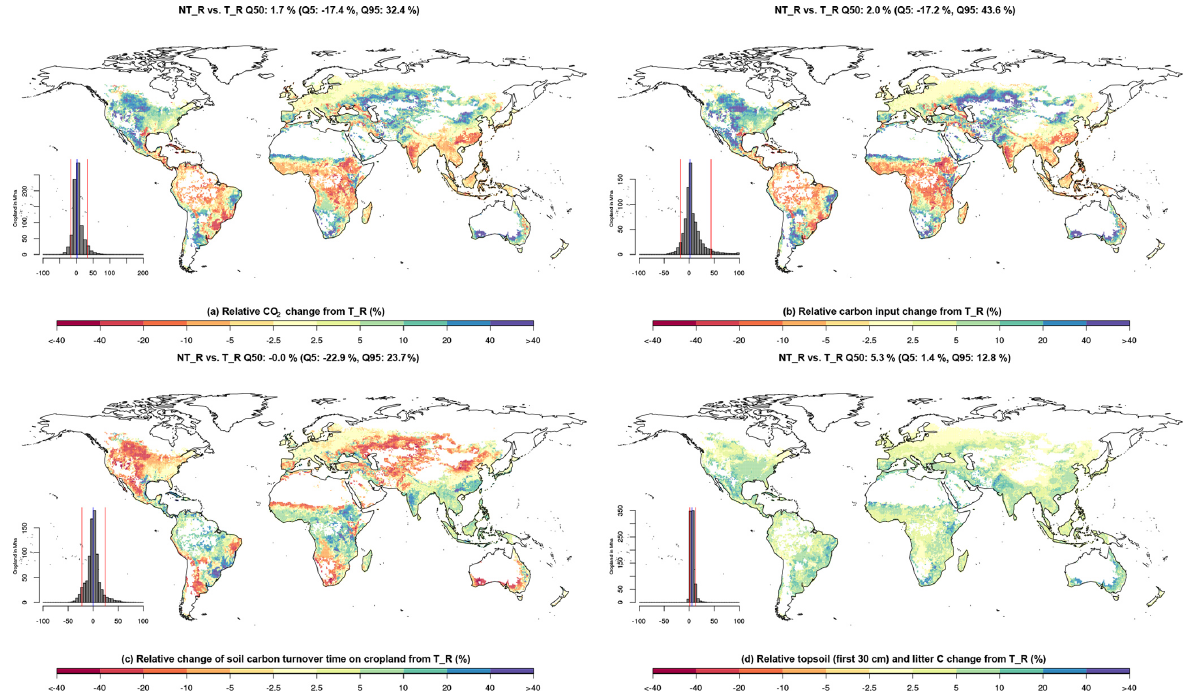
Figure 3. Relative C dynamics for NT_R vs. T_R comparison after 10 years of simulation experiment (average of year 9–11) for relative CO 2 change (a) , relative C input change (b) , relative change of soil C turnover time (c) , and relative topsoil and litter C change (d)